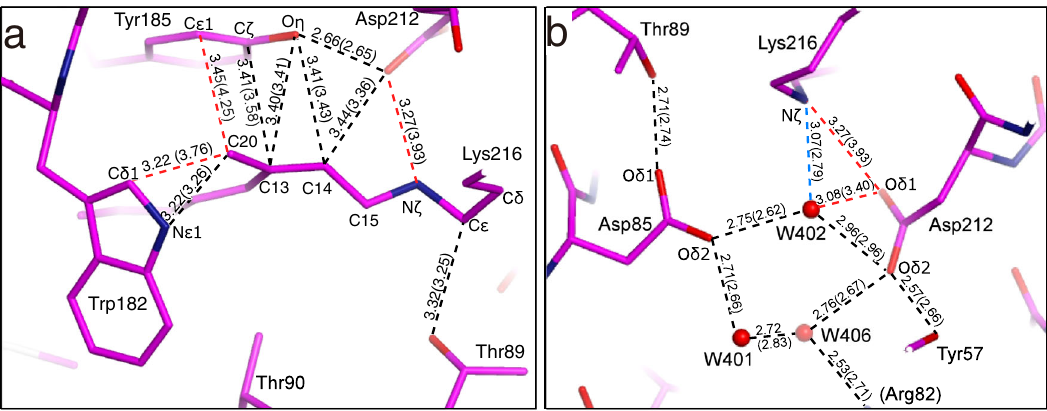
Fig. 4 Details of interactions in the K intermediate. a Interatomic distances of <3.5 Å between retinal and the surrounding residues are shown, while those for the ground state are in parenthesis. The dotted lines are colored according to the changes of the distances upon the K formation, with red and blue indicating a large (>0.2 Å) decrement and large increment, respectively. b Hydrogen bonds with distances of <3.5 Å on the EC side of the SB linkage are shown, while those for the ground state are in parenthesis.